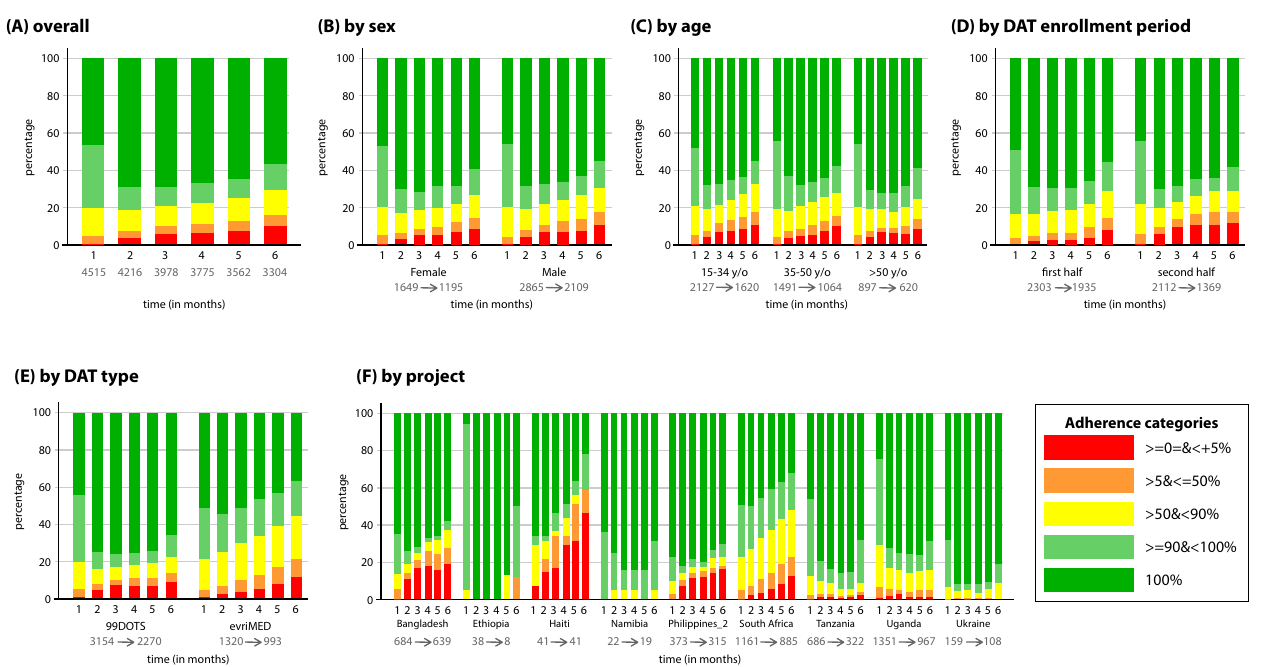
Figure 1. Frequency graphs of TB treatment adherence categories for DS-TB population over the (first) six treatment months. The proportion of patients belonging to a certain adherence category is depicted on the y -axis, and the six treatment months are depicted on the x -axis. ( A ) Monthly adherence for all patients. ( B ) Monthly adherence split up by sex. ( C ) Monthly adherence split up by age category. ( D ) Monthly adherence split up by DAT enrollment period. ( E ) Monthly adherence split up by DAT type. ( F ) Monthly adherence split up by project. Underneath each subgroup two numbers are placed; these resemble the sample size at month one (before arrow) and month six (after arrow). Number of patients at each month is given in the overall graph. DAT = digital adherence technology; y/o = years